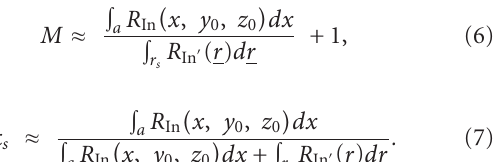
the fission cross-section, φ s the neutron flux at position r with energy E in the presence of an external source, and a the In wire along the fuel regions (SV and fuel